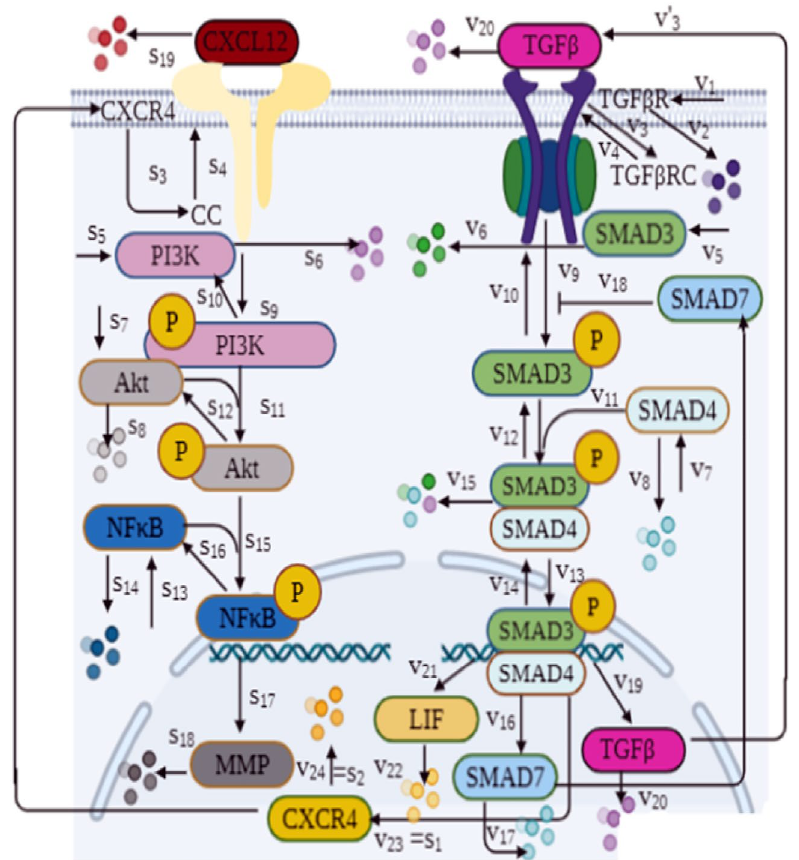
Figure 2. Biochemical reactions involved in dynamical model of TGFβ and CXCL12 pathways as well as their crosstalk within a cancer cell. The name of each reaction is shown on the corresponding arrow. More information about the mathematical representation of reactions are included in Tables 1, S1, and